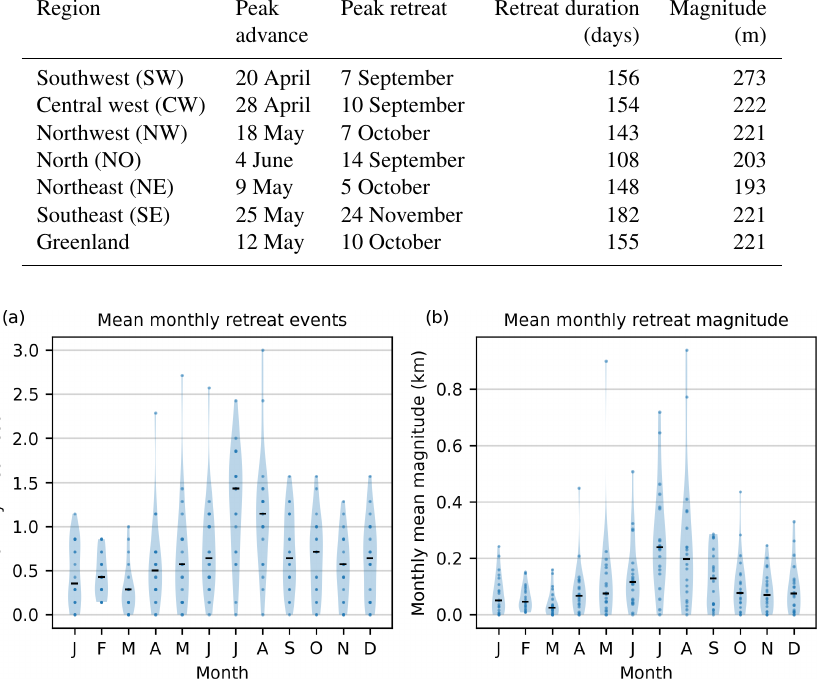
Figure 5. Distribution of the monthly (a) number and (b) magnitude of retreat events for each of the weekly glaciers. The width of the shaded region represents the likelihood of a given (a) number or (b) magnitude of retreat events occurring in a given month. Horizontal black bars show the median for each month, and blue dots show the values for individual